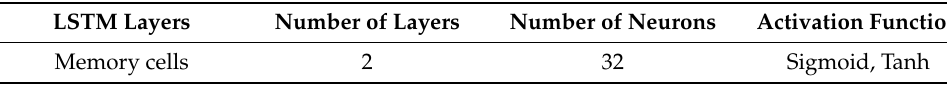
Table 3. Structure of LSTM in the CNN-LSTM model.